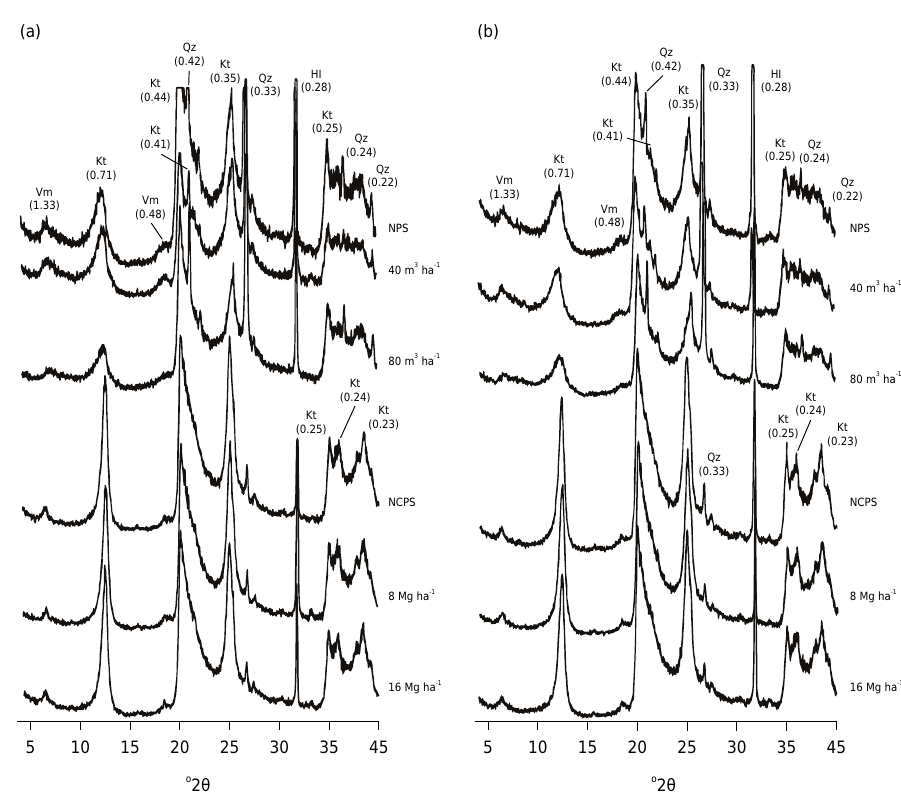
Figure 2. Clay fraction X-ray diffractograms of samples treated with DCB of a Typic Rhodudalf (NPS, 40 m 3 ha -1 and 80 m 3 ha -1 ) and of a Typic Hapludox (NCPS, 8 Mg ha -1 and 16 Mg ha -1 ), from the 0.00-0.04 m layer (a) and 0.04-0.08 m (b). d spacing in nm. Vm = vermiculite; Kt = kaolinite; Qz = quartz; Hl =